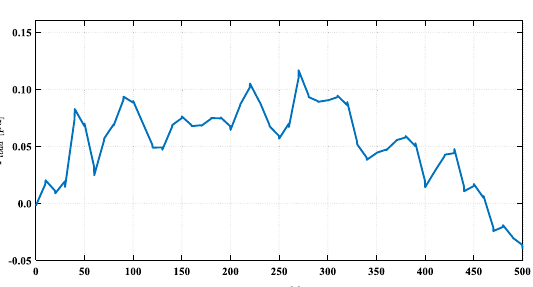
Fig. 10 The load power fluctuation of Case 2